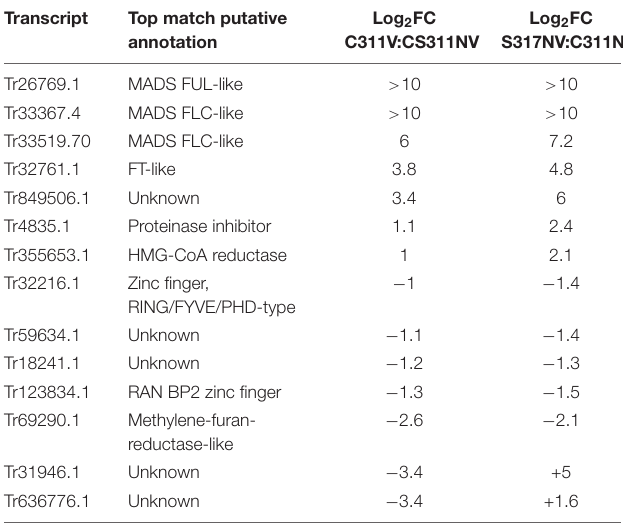
TABLE 1 | List of 14 differentially expressed safflower transcripts identified during a vernalization treatment in a winter variety and in a comparison of transcripts differentially expressed in a non-vernalized treatment of the winter and spring